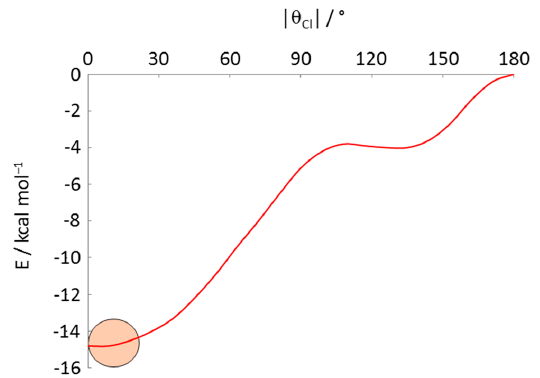
Figure 10. Plot of energy vs. | θ Cl | for [3,3-(PH 3 ) 2 -3-Cl- closo -3,1,2-RhC 2 B 9 H 11 ] by DFT calculation. The | θ Cl | values of the compounds in Table 5 all fall within the pink circle.